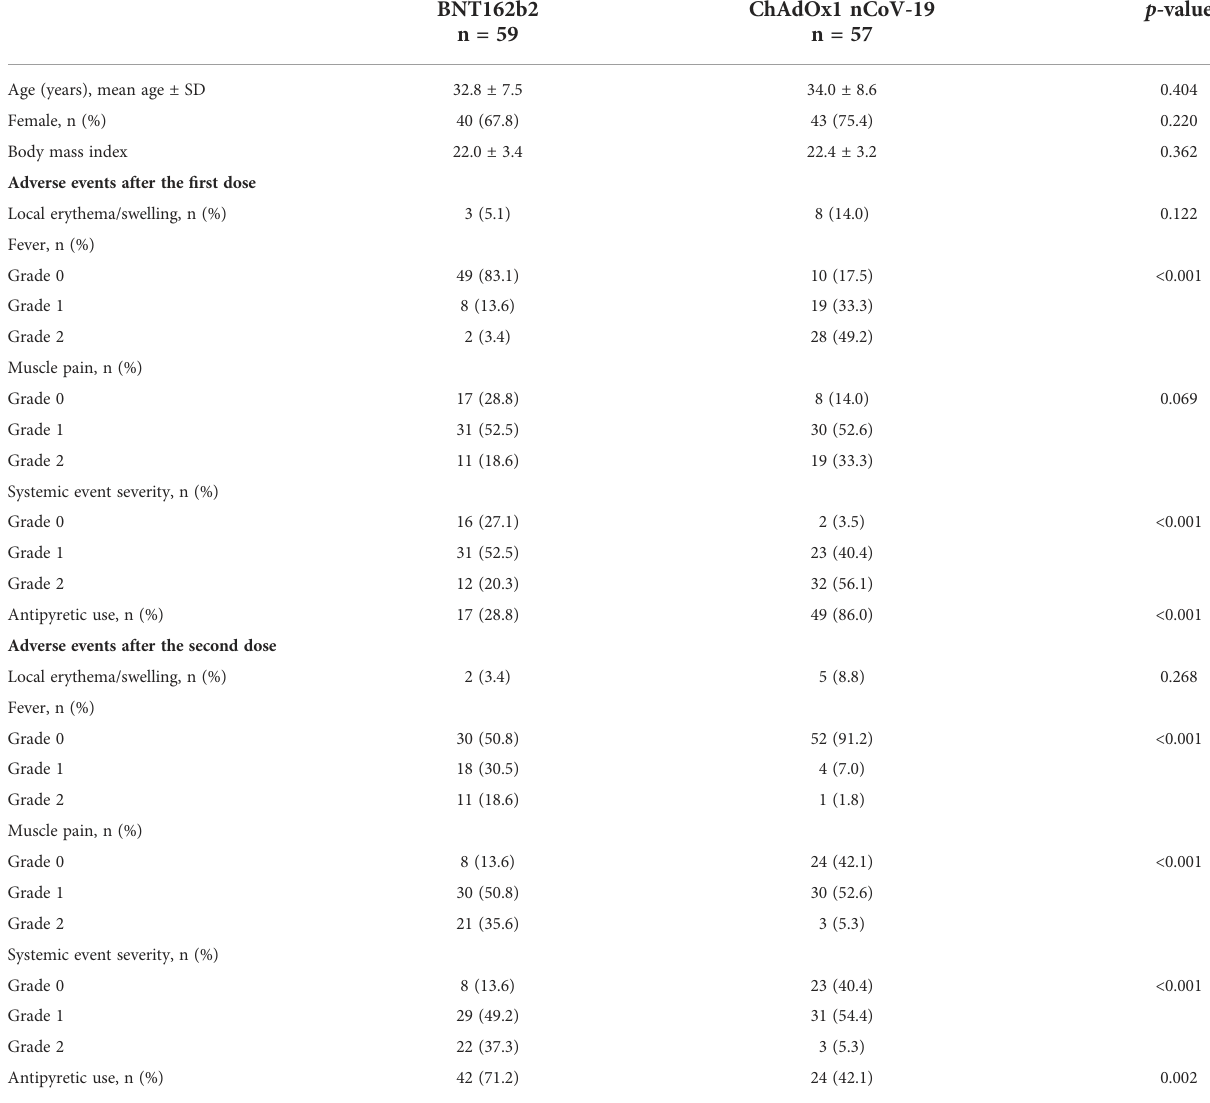
TABLE 1 Patient demographics and adverse events after the fi rst and second doses of BNT162b2 and ChAdOx1